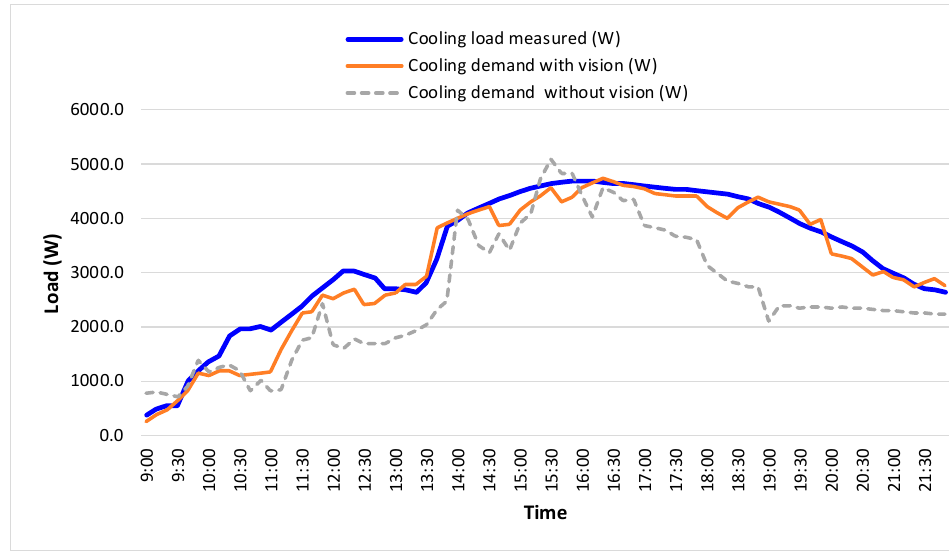
Figure 17. Instantaneous load in one day.